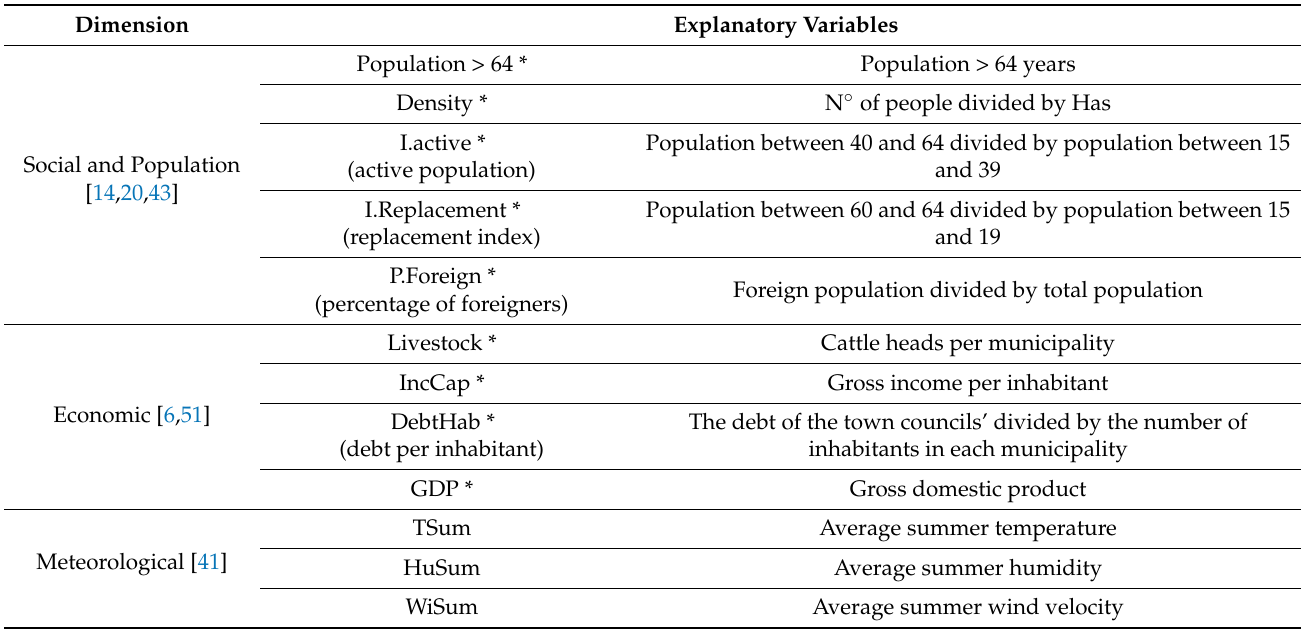
Table 1. Variables selected for the